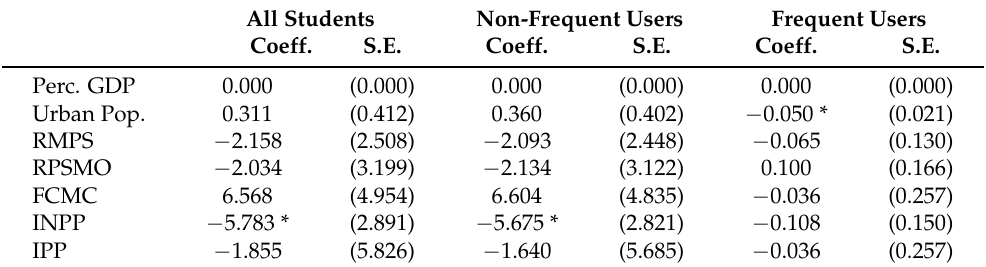
Table 4. Estimated association between cannabis policy reforms and changes in the share of all students, non-frequent users and frequent users considering easy to find